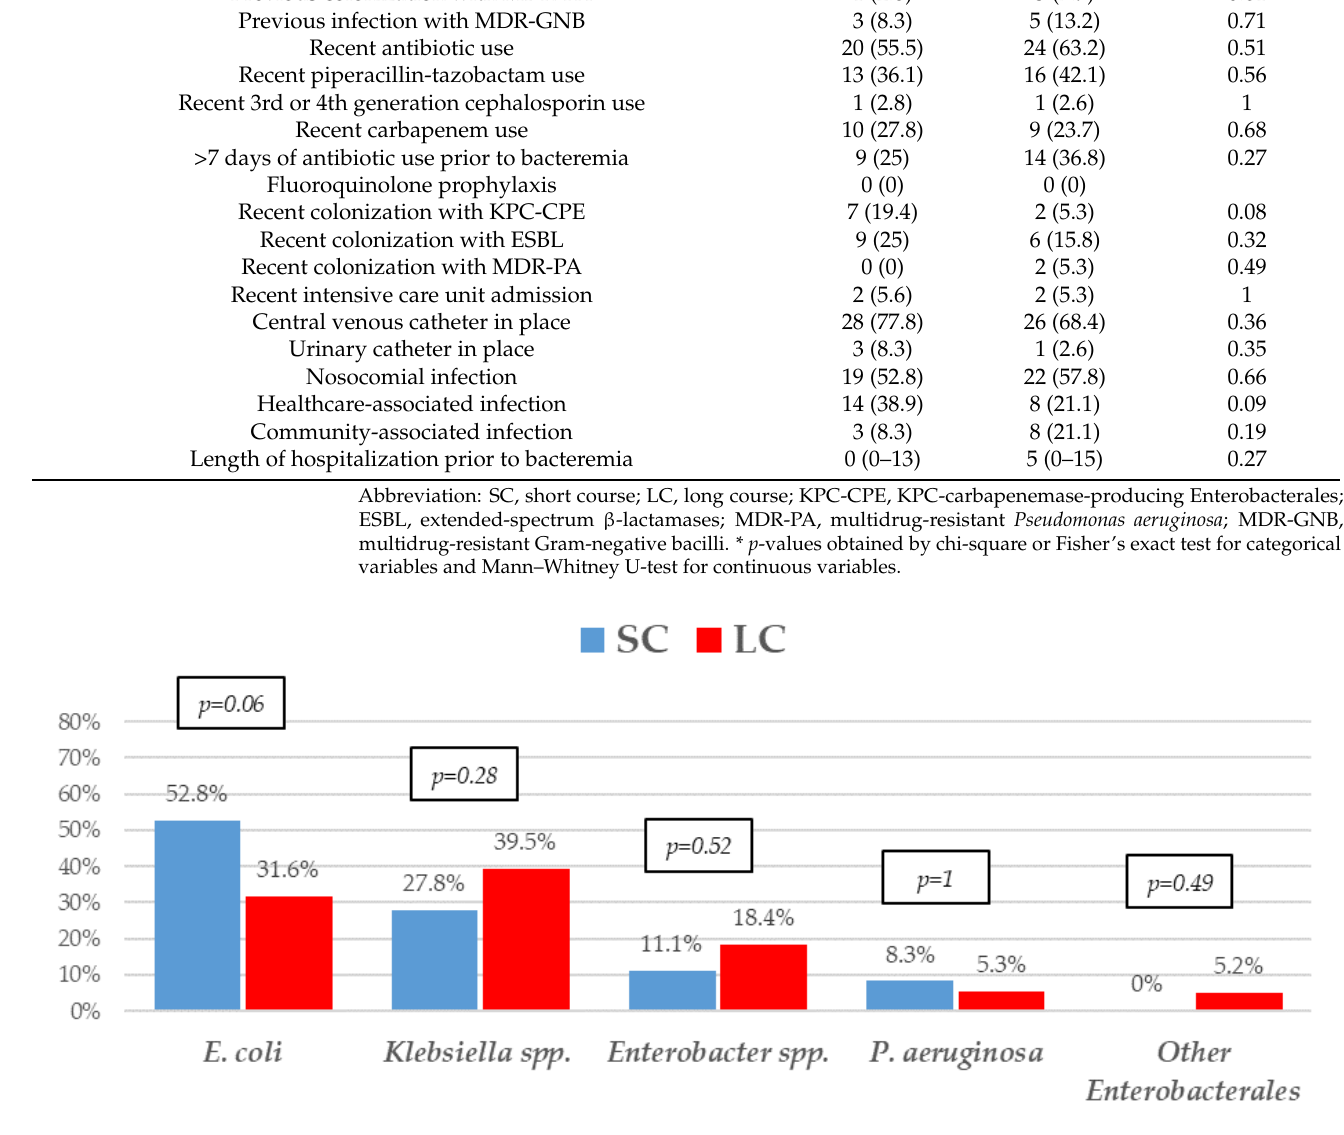
Figure 1. Etiology of Gram-negative bacilli bacteremia treated with a short course (SC) or long course (LC) of antibiotic therapy. p -values obtained by chi-square or Fisher ’ s exact test.